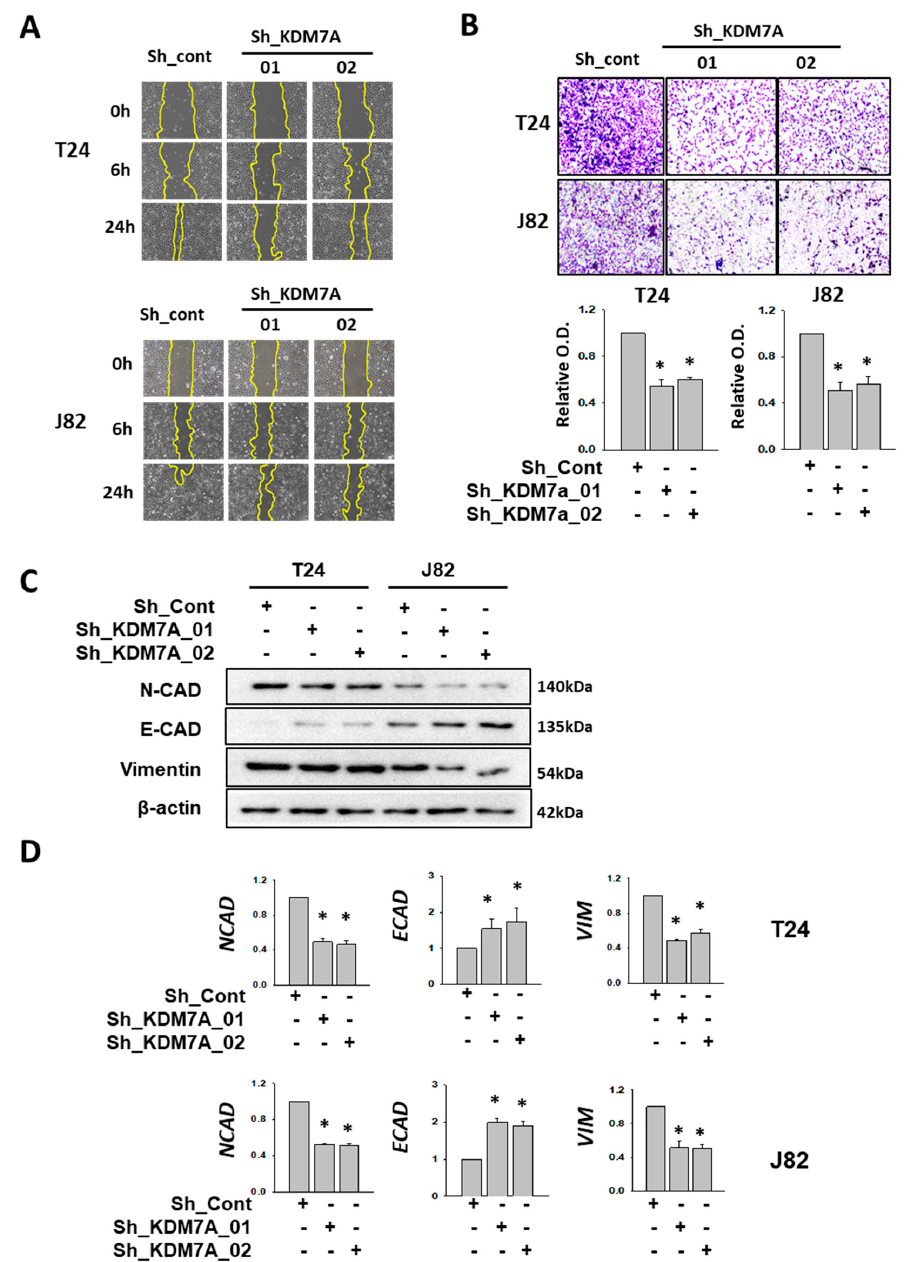
Figure 4. KDM7A knock-down reduced cell mobility and EMT-related gene expressions in bladder cancer cells. ( A ) Scratch-wounding cell migration assay of the control and KDM7A shRNA-expressing cells was performed for the indicated time. The wound margin is marked with a yellow line. ( B ) The Transwell assay of the same number of control and KDM7A shRNA-expressing cells. At 48 h after plating, cells that had migrated to the underside of the filters were fixed and stained with crystal violet. Photographs were taken and the relative cell migration was determined by measuring OD 495 after extraction. Bars represent means ± SD of three independent experiments. * p < 0.05 (Student’s t -test) versus the control shRNA (sh-cont) group. ( C ) The protein levels of indicated EMT markers were measured from the whole cell extracts of control or KDM7A knock-down cells. ( D ) The mRNA levels of the indicated EMT marker genes were measured from cell lines with control or KDM7A shRNA expression. Bars represent means ± SD of three independent experiments * p < 0.05 (Student’s t -test) versus the sh-cont